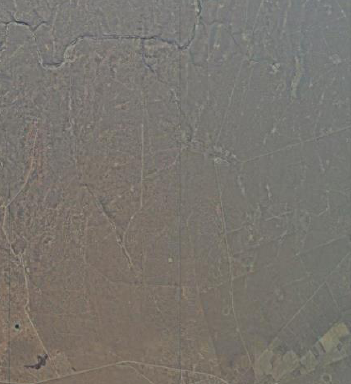
Fig.9 The four images after color balance of the